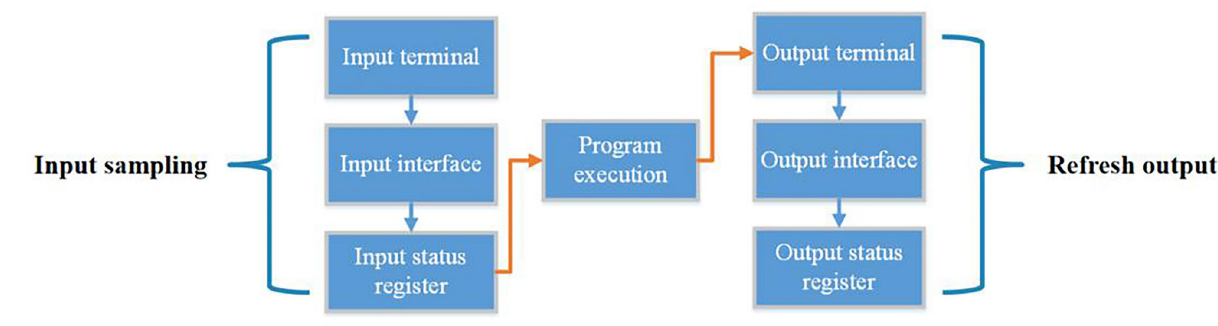
Fig 5. PLC working principle operation